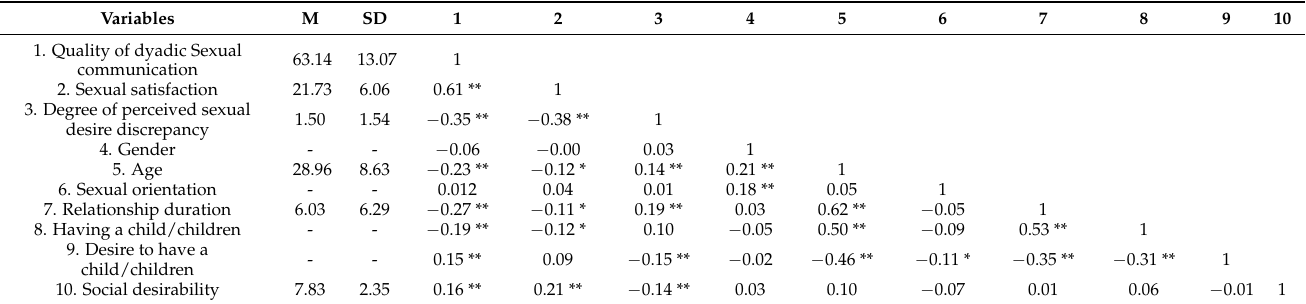
Table 2. Results of the three mediation models.